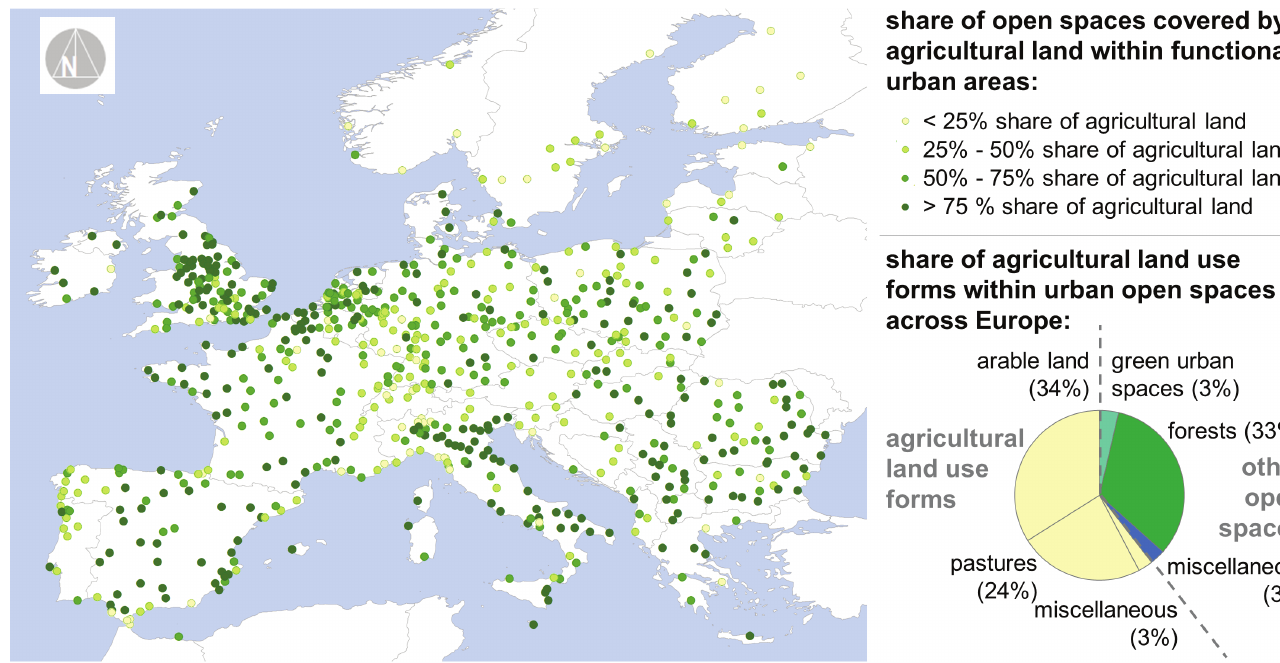
Figure 3. The high share of functional urban areas by utilizable agricultural land – i.e. ‘peri-urban farmland’ offer spatial potentials contributing to UGI connectivity and multifunctionality (Calculation based in Urban Atlas data (EEA